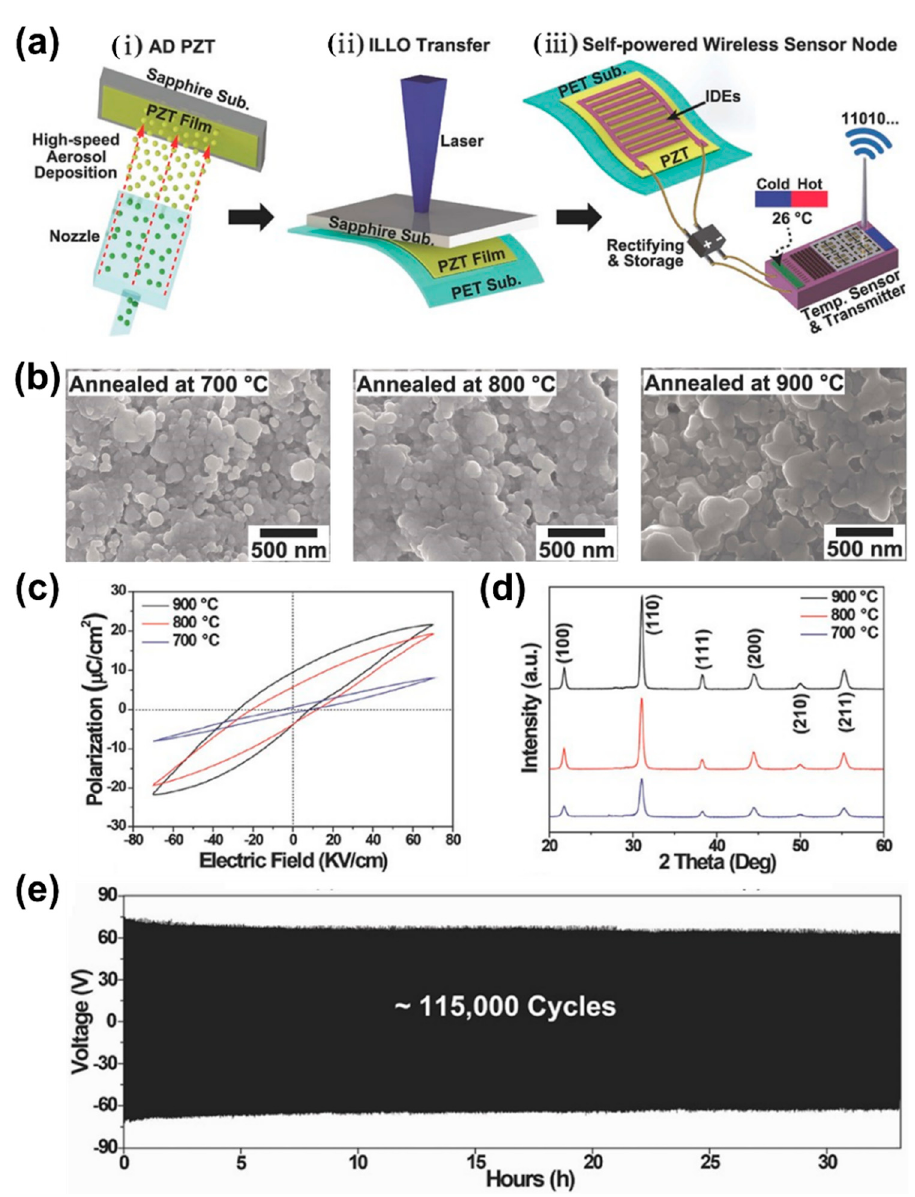
Figure 10. ( a ) Schematic diagram of the device fabrication and self − powered IoT using flexible AD PZT film by ILLO process. ( b ) SEM image of AD PZT films grown on sapphire wafers and annealed at 700, 800 and 900 °C for 1 h. ( c ) P − E hysteresis loops of annealed PZT films. ( d ) XRD patterns of annealed PZT films. ( e ) The bending durability test results of the flexible energy harvester for 115,000 cycles. Reproduced with permission [119].